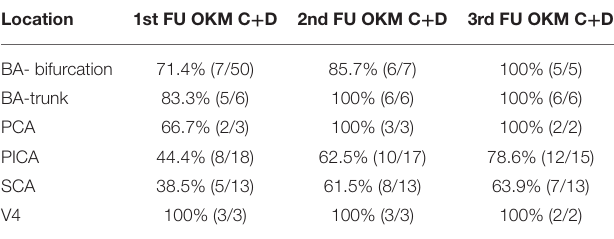
TABLE 3 | Aneurysmal location and angiographic occlusion rates at each time point.